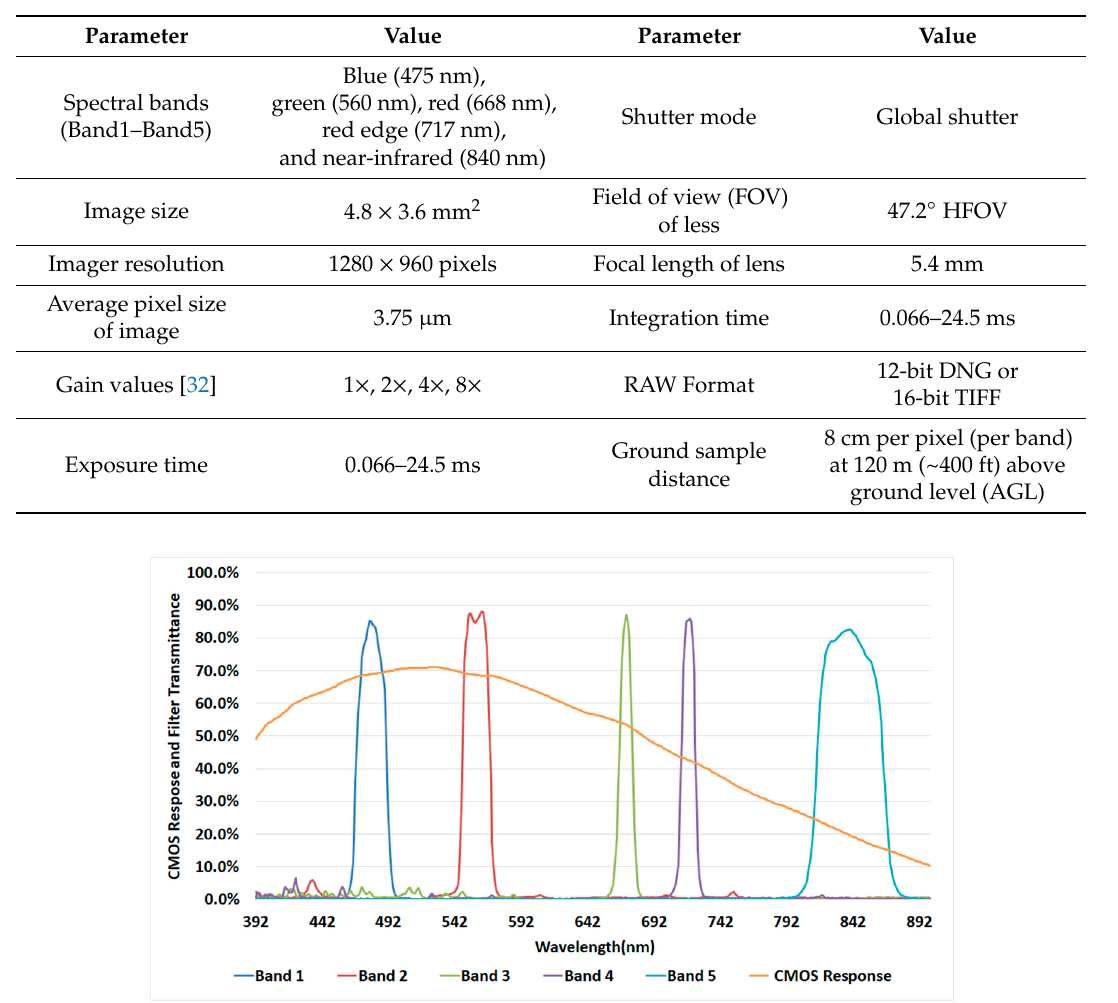
Table 1. Characteristics of sensors and lens.